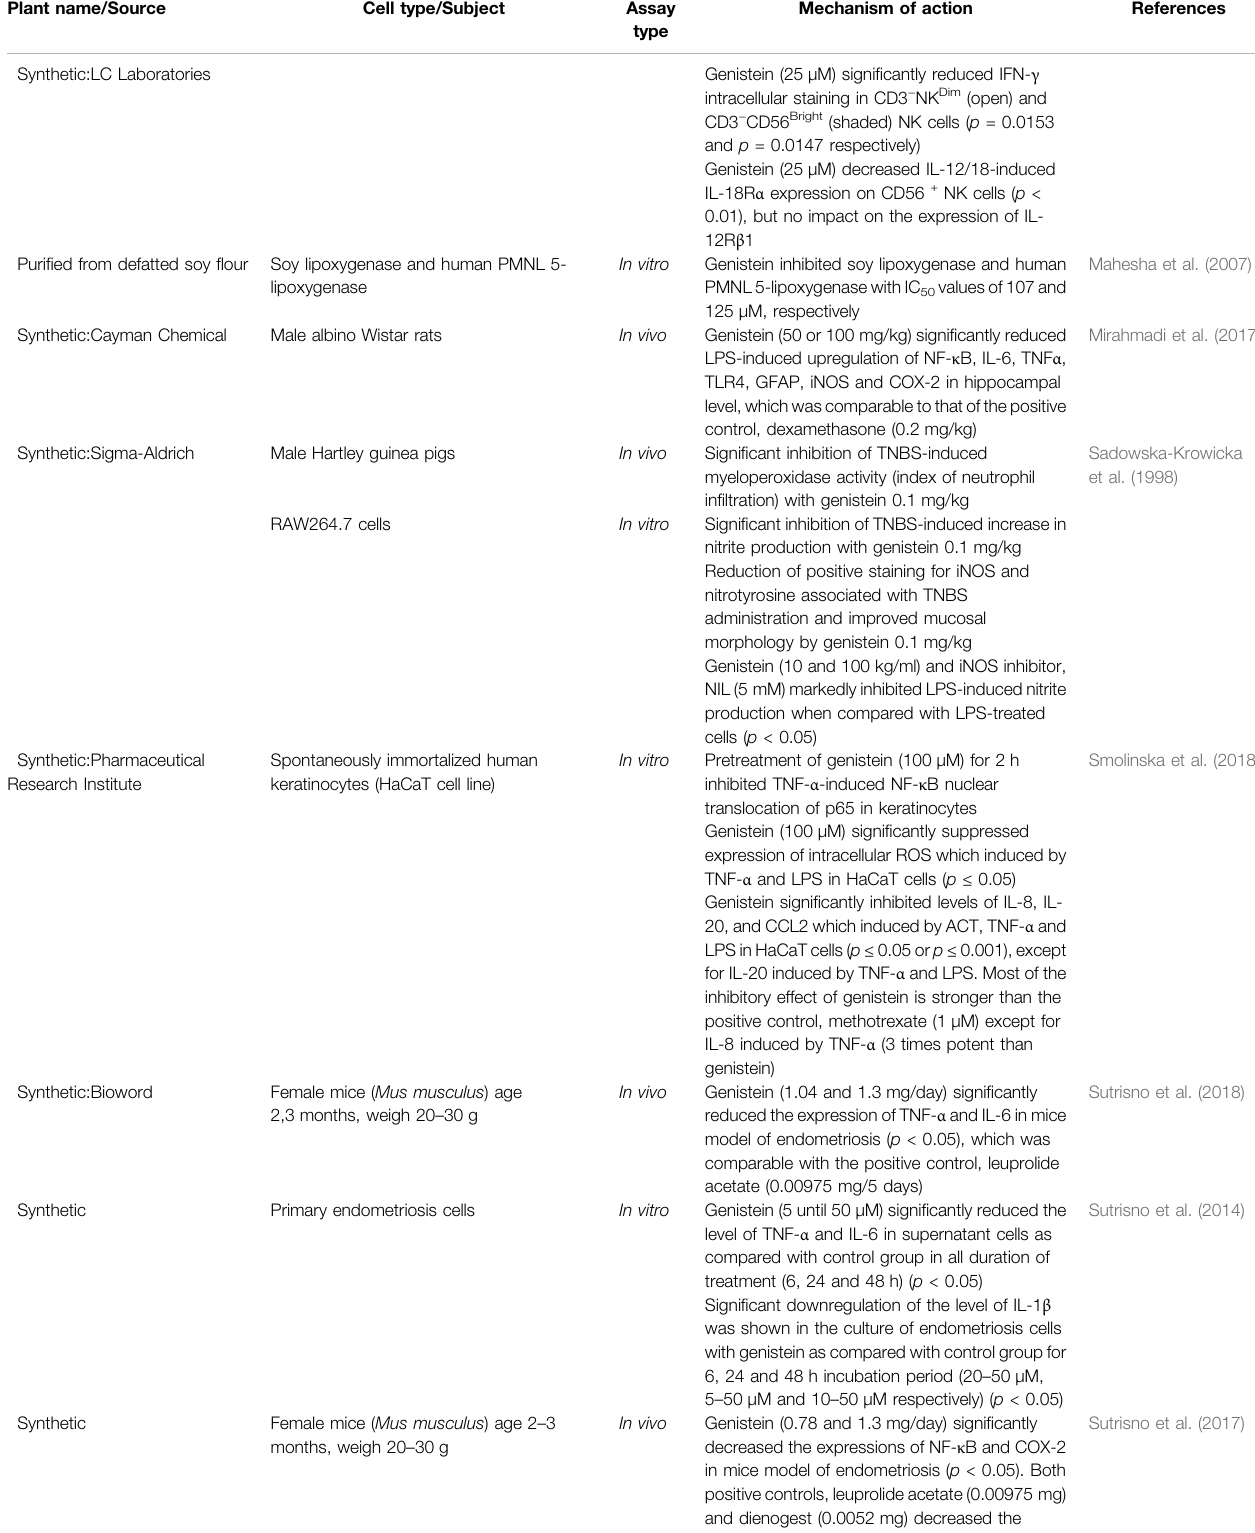
TABLE 1 | ( Continued ) Genistein with potent anti-in fl ammatory